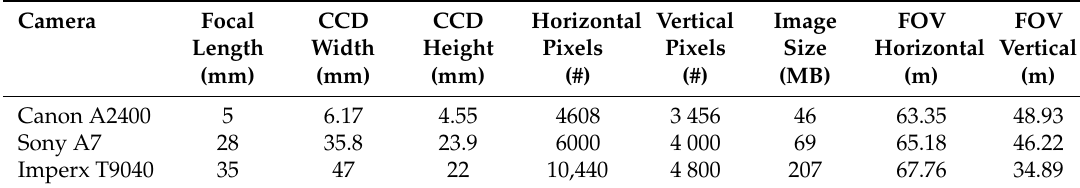
Table 3. Characteristics of the cameras used in the